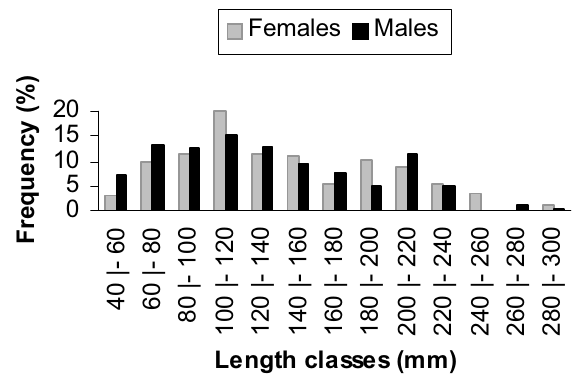
Fig. 9. Relative frequency distribution of males and females of Gymnotus aff. carapo by total length classes in lagoa Verde, Itapuã State